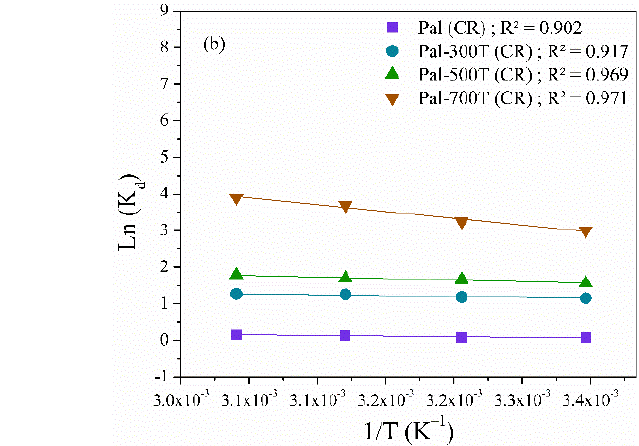
Figure 8. Van’t Hoff plots to determine different thermodynamic parameters in dye removal ( a ) CV and ( b ) CR. Table 5. Thermodynamic parameters for CV and CR adsorption in palygorskite before and after heat treatment at different temperatures.